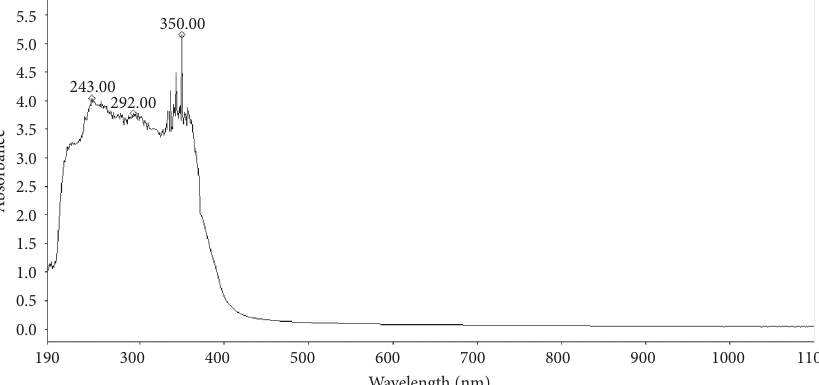
Figure 3: Specific wavelengths of CuO NPs using propolis (Gilan) extract in UV-Vis spectrophotometry assessment.